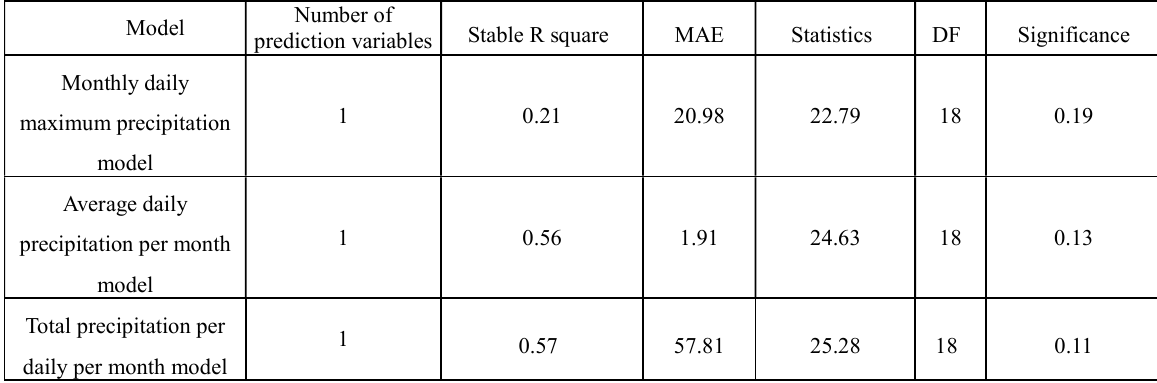
Table 1. Statistical of Guilin precipitation model from 2014 to